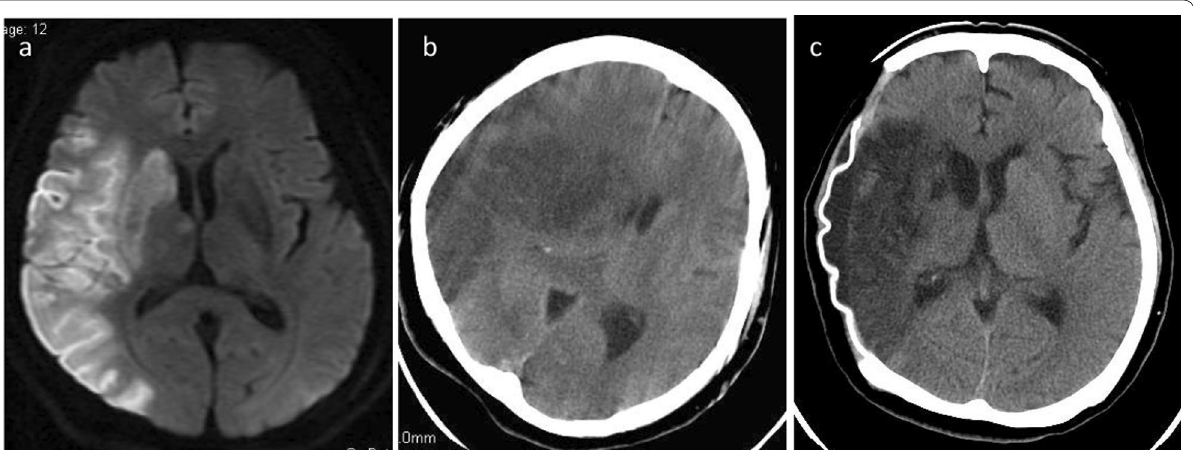
Fig. 1 Brain MRI shows massive cerebral infarction of the right middle cerebral artery area ( a ). Brain CT shows diffuse brain edema resulting in brain herniation ( b ), and no cerebral edema after external decompression ( c )